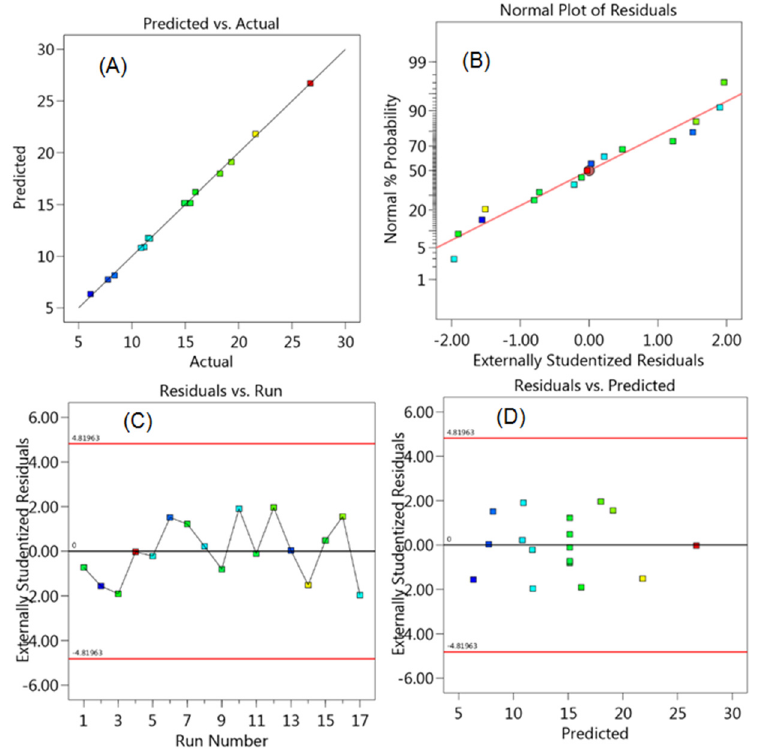
Figure 3. Diagnostic plots for resolution of MFH to RGE showing the predicted vs. actual ( A ) normal plot of residuals ( B ), residuals against run ( C ) and predicted values ( D ).